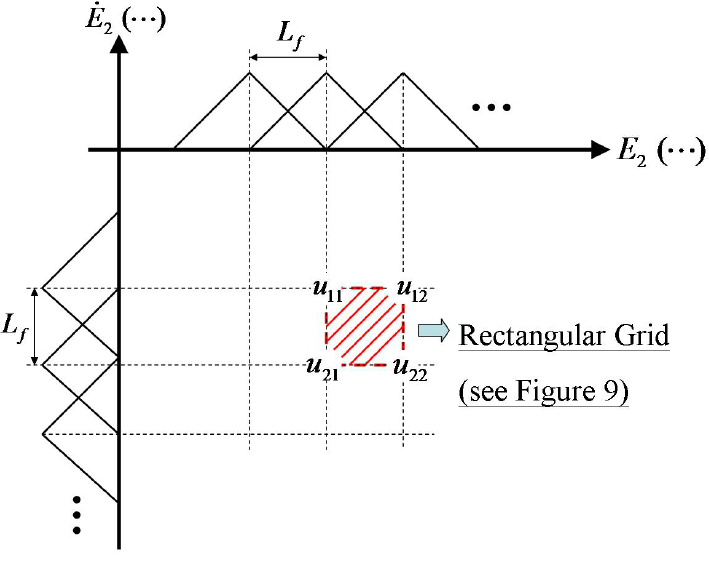
Figure 7. Membership functions for fuzzy variables.